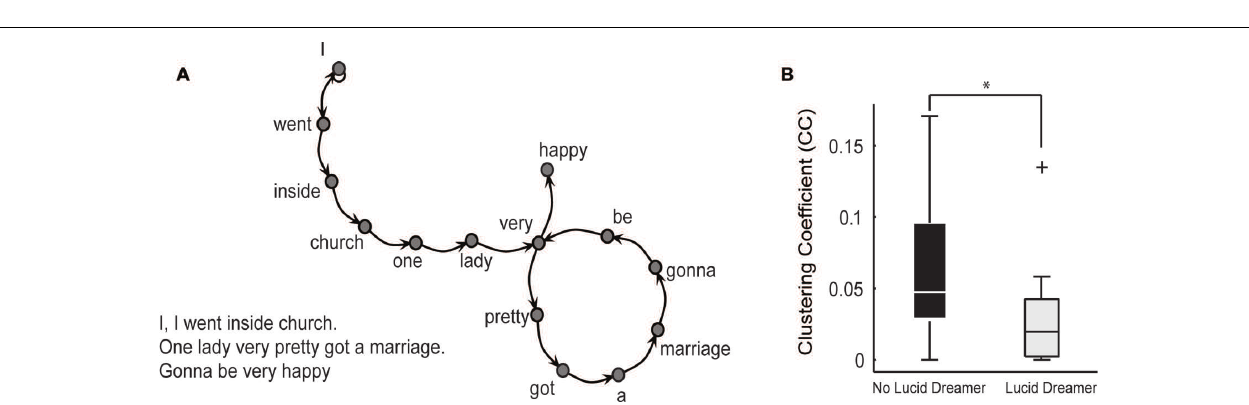
FIGURE 4 | Differences on speech structure when reporting a regular dream between lucid dreamers and non-lucid dreamers among schizophrenia patients. (A) Example of a text (regular dream report) represented as a speech graph. For this plot the original text was in Portuguese and each word was translated to English, preserving the original grammatical structure. Speech graph attributes (SGA, see Table 2 ) were used to characterize speech structure from dream reports. (B) In the S group, speech graphs from dream reports of lucid dreamers showed smaller clustering coefficient (CC) than non-lucid dreamers ( p = 0.0171) ( ∗ p <